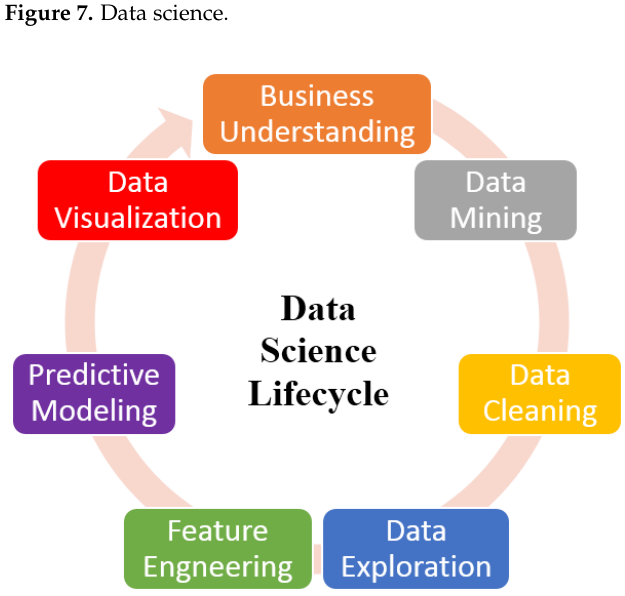
Figure 8. Data science lifecycle.